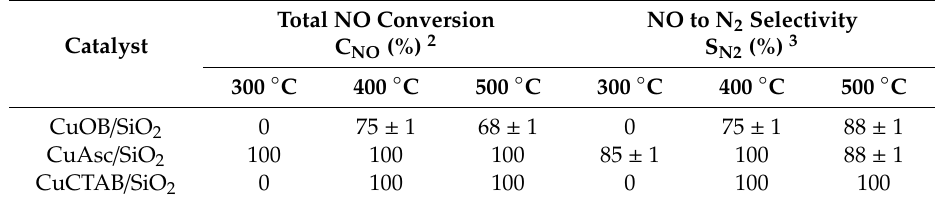
Table 4. NO conversion and NO to N 2 selectivity from the catalytic tests 1